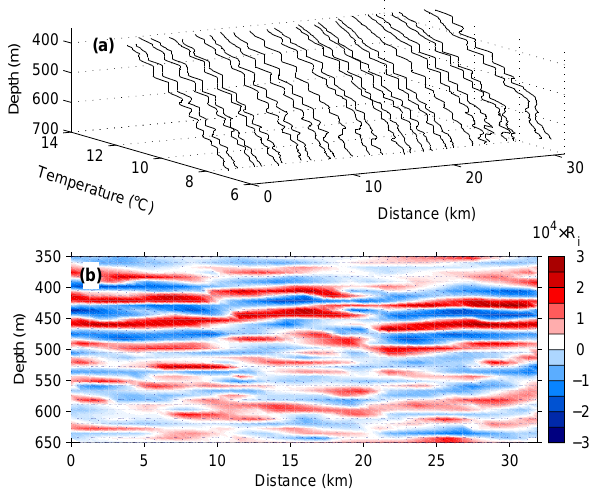
Fig. 7. (a) Three-dimensional view of CTD tow-yo temperature profiles collected during C-SALT at a strong, well-defined thermo- haline staircase (Schmitt et al., 1987). Distance is inferred from the cumulative great-circle distance between the position at the start of each subsequent cast. (b) Reflection coefficients calculated from the C-SALT CTD tow-yo shown in (a). Peaks in reflection coefficient correspond to sharp changes in sound speed.